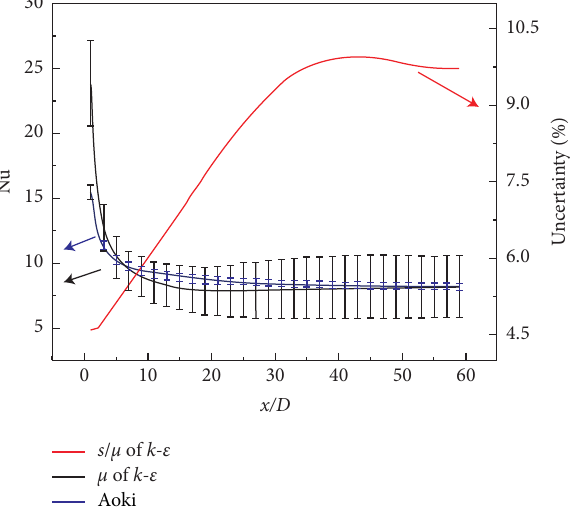
Figure 1: Axial uncertainty quantification of Nu with 6s uncertainty.